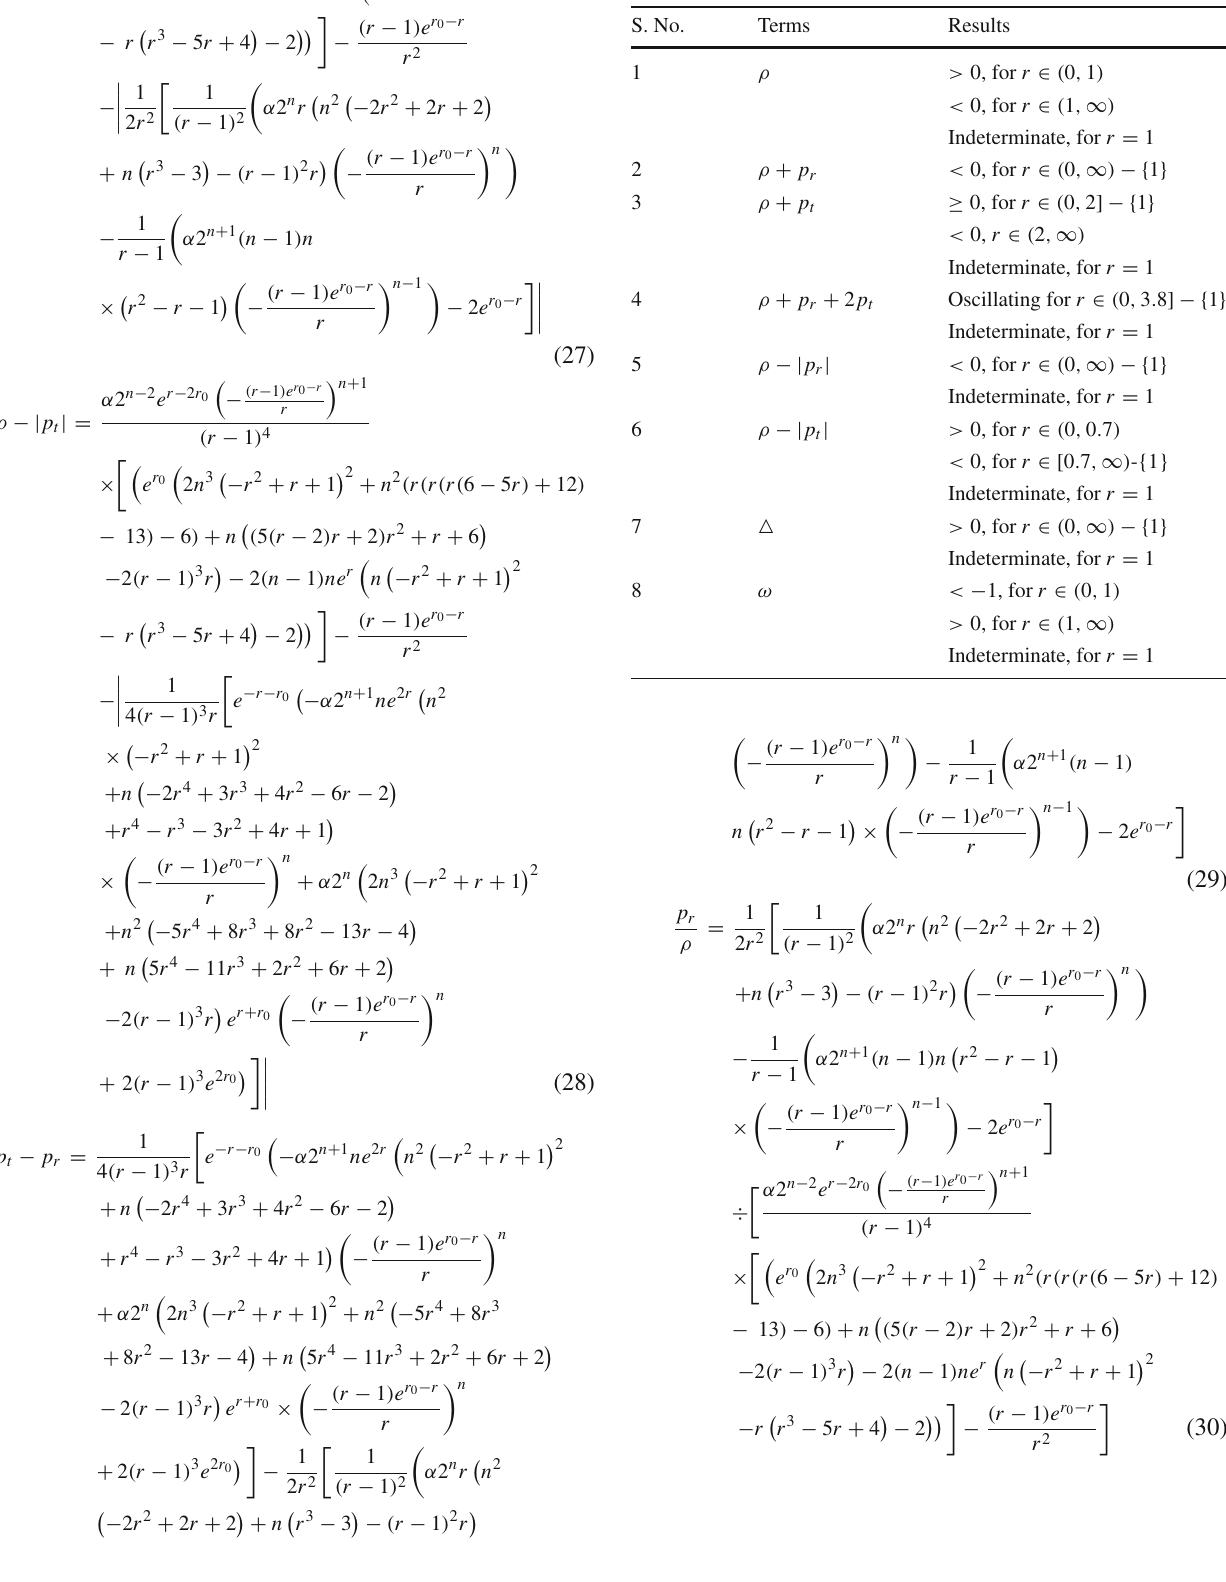
Table 1 Summary of results for φ( r ) = constant with α =